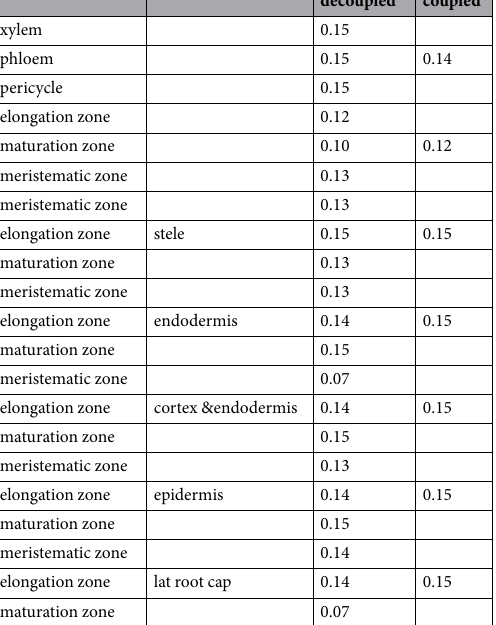
Table 5. Optimal regulation coefficient λ . The underlying principle of RegrEx 12 is the LASSO approach 45 , in which a regularization term can be controlled by the coefficient λ . In RegrEx, it also controlled the number of reactions that were extracted from the initial genome-scale model. From a series of λ ranging between 0 and 0.15 with a step size of 0.01 an optimal value was given when the Pearson correlation between the predicted flux values and the transcriptomics data was maximum. For all three scenarios Li 1, Li 2 and Birnbaum this was checked for the (de)coupled